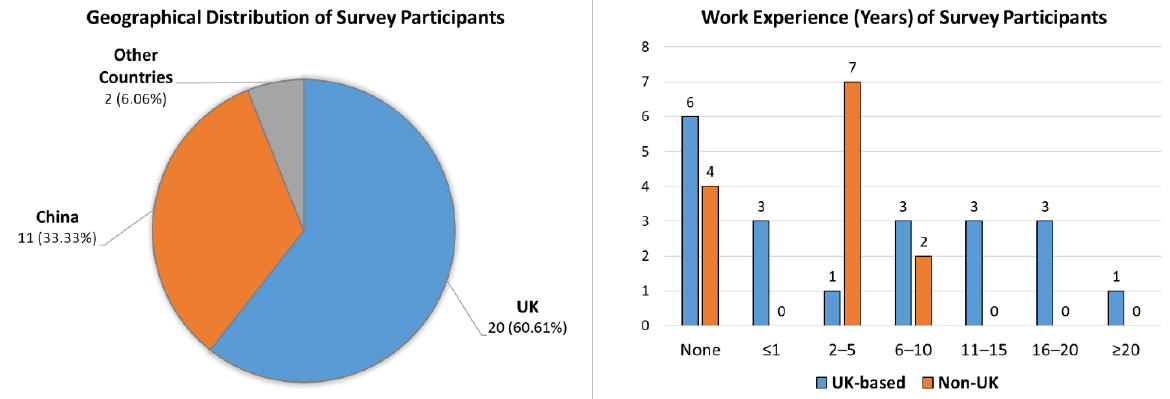
Figure 5. Distribution of survey p articipants ‘Country of Residence’ and ‘Work Experience’ .